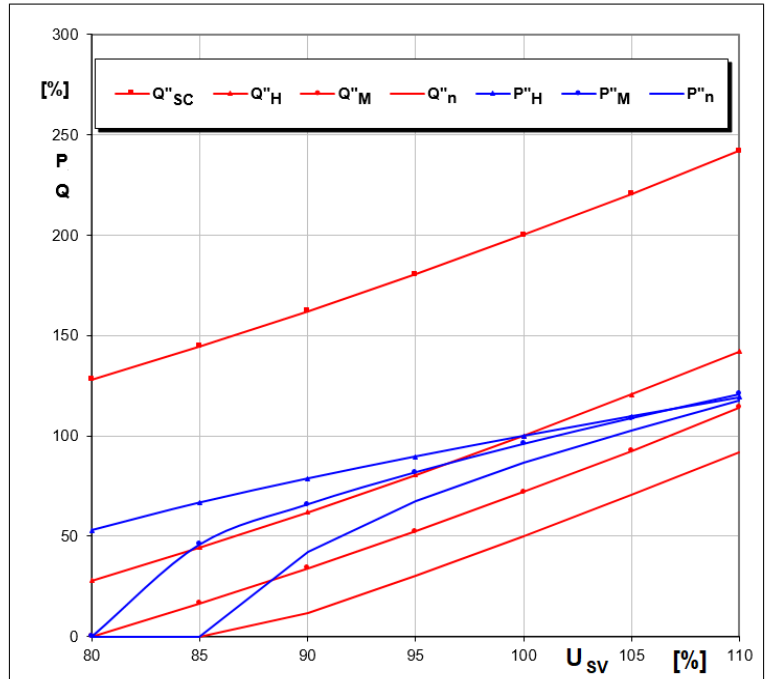
Figure 10. Changes of reactive and active power as a function of supply voltage—operation at a constant arc voltage value ( U Arc = const).